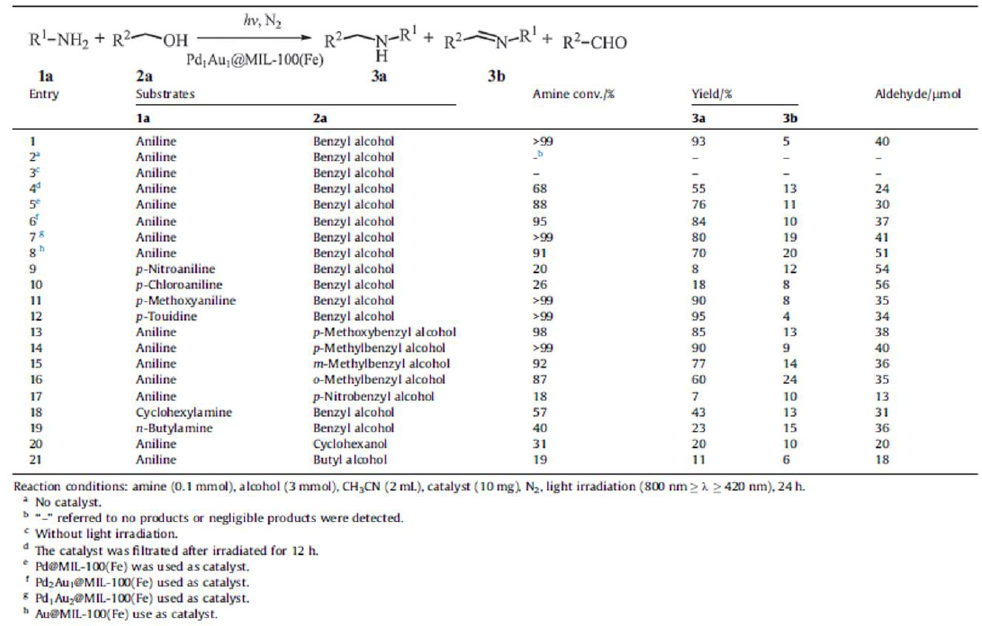
Figure 7. Light-induced catalytic performance for N-alkylation of amines with alcohols over Pd 1 Au 1 @MIL-100(Fe). Reproduced with permission from Reference [92]. Copyright 2018 Elsevier Inc.